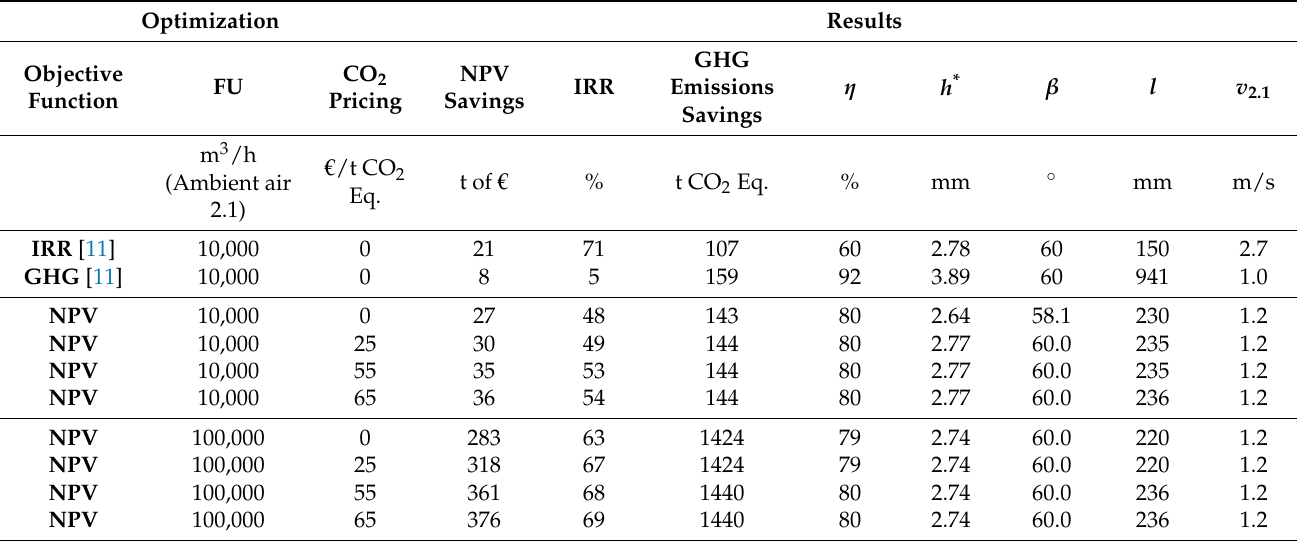
Table 5. Optimization results NPV and IRR, CO 2 Eq.